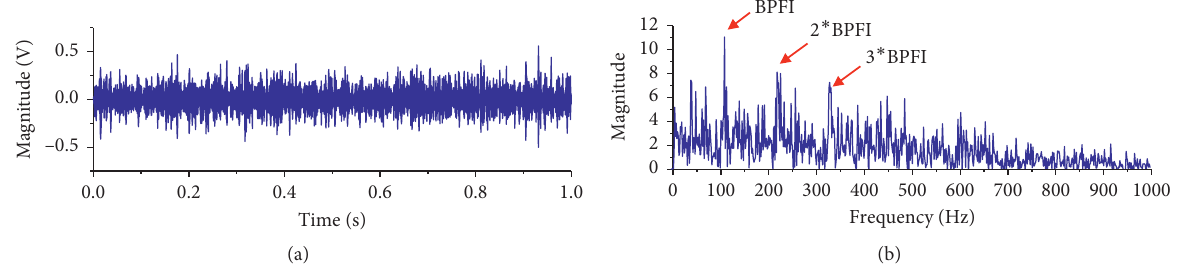
Figure 4: Analysis results of the simulated signal by the proposed method. (a) The result of the peak-based mode decomposition. (b) Envelope spectrum of the result.